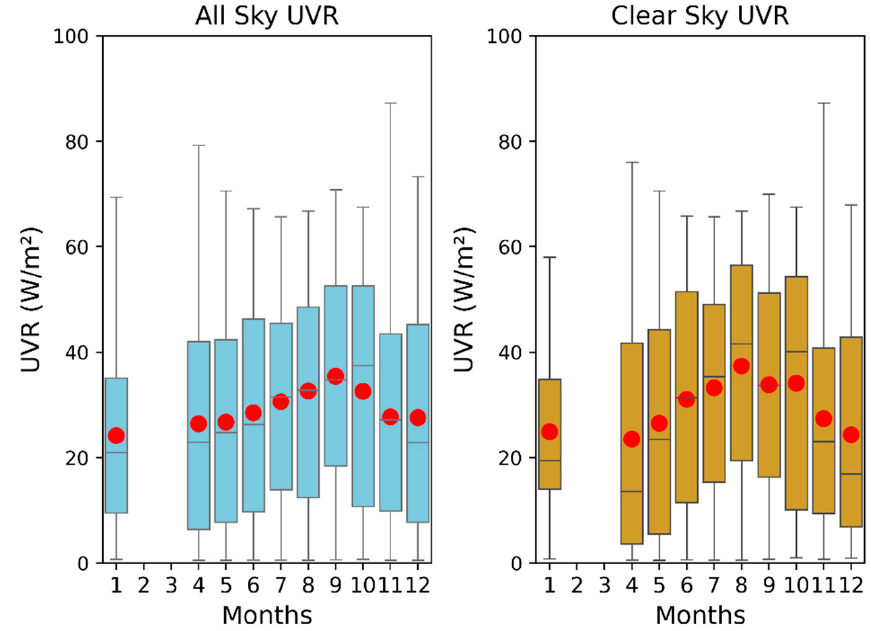
Figure 7. UVR monthly average in all sky and in clear sky condition.